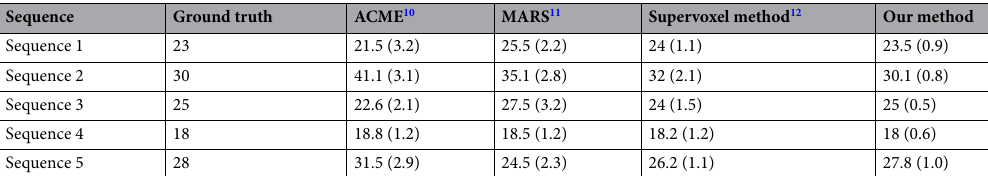
Table 5. Cell counting accuracy for different methods. For each time sequence, there is a fixed number of cells. Due to segmentation error, the algorithms can generate different number of cells for different time points of the sequence. The table shows average number of detected cells (standard deviation values in parenthesis) for the entire sequence.